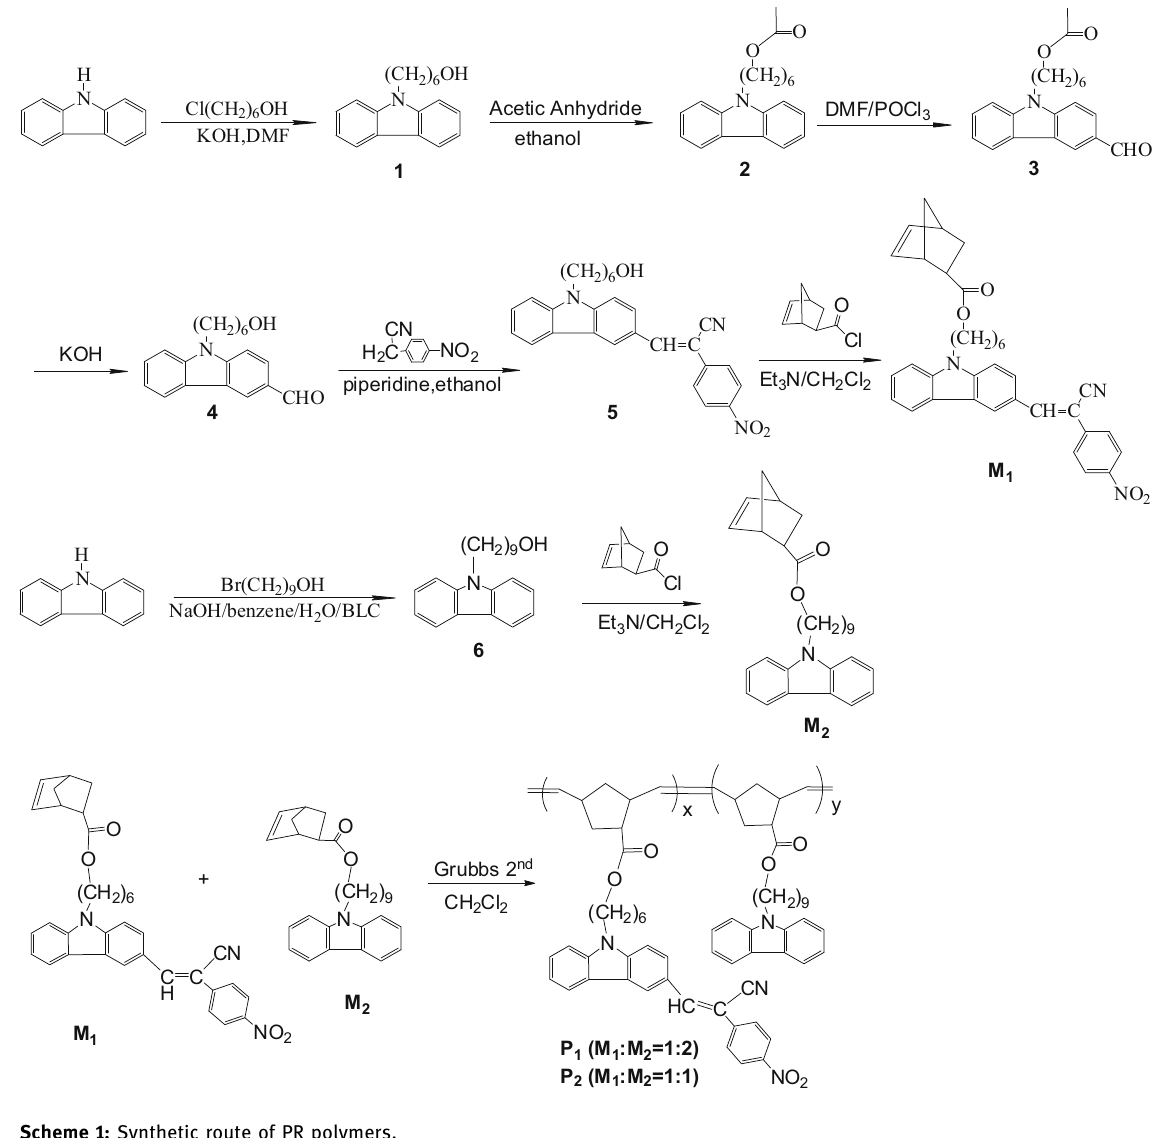
Scheme 1: Synthetic route of PR